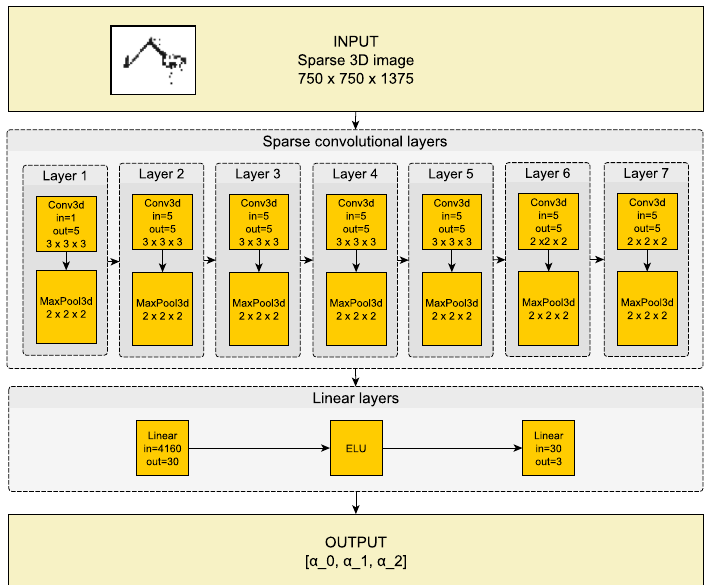
Figure 8. Structure of a sparse convolutional neural network with a sparse image in input and the robot state (angles α 0 , α 1 , α 2 ) on the